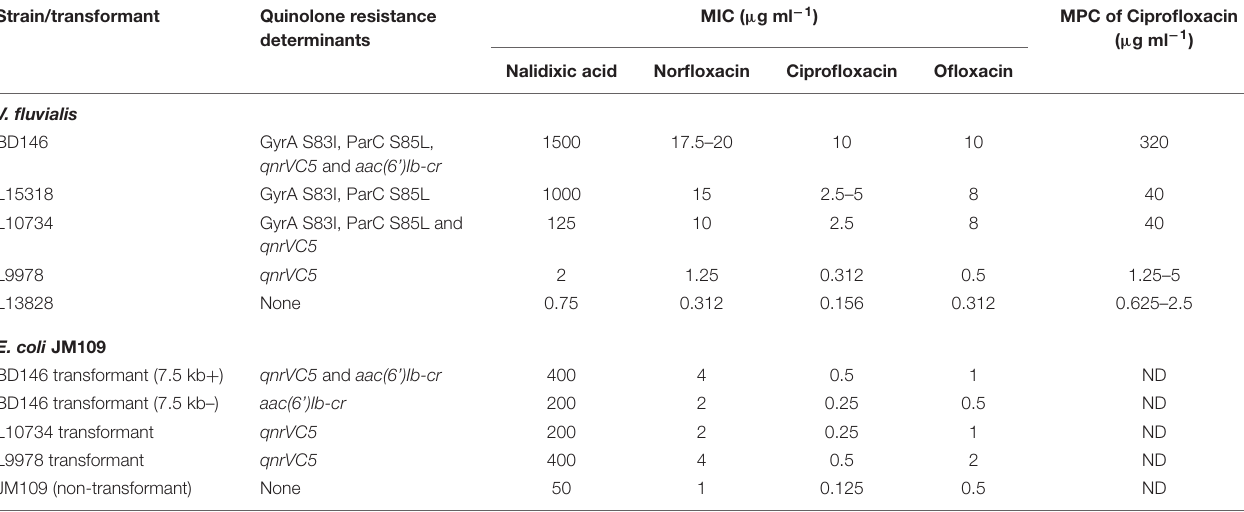
TABLE 1 | Quinolone susceptibility of V. fluvialis strains and their corresponding E. coli transformants. Strain/transformant Quinolone resistance